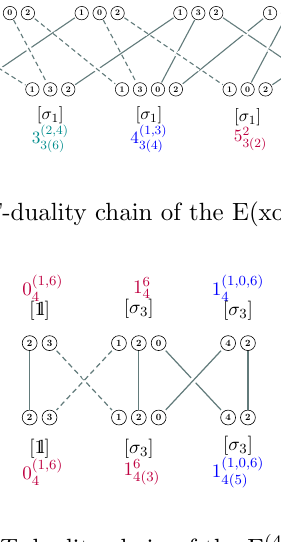
Figure 5 . T -duality chain of the E (4;6)